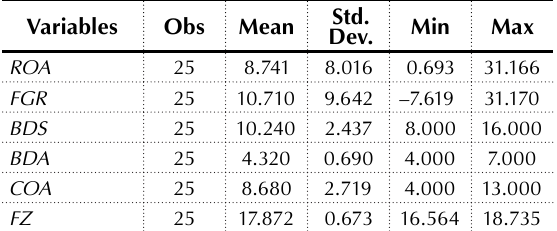
Table 1. Summary statistics of the variables